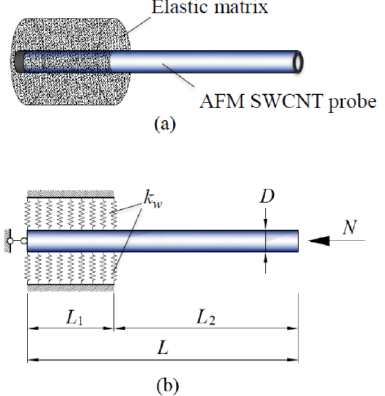
Figure 7. ( a ) A proposed carbon nanotubes-based nano-force sensor, and ( b ) the analytical model of the partial embedded carbon nanotubes resonator